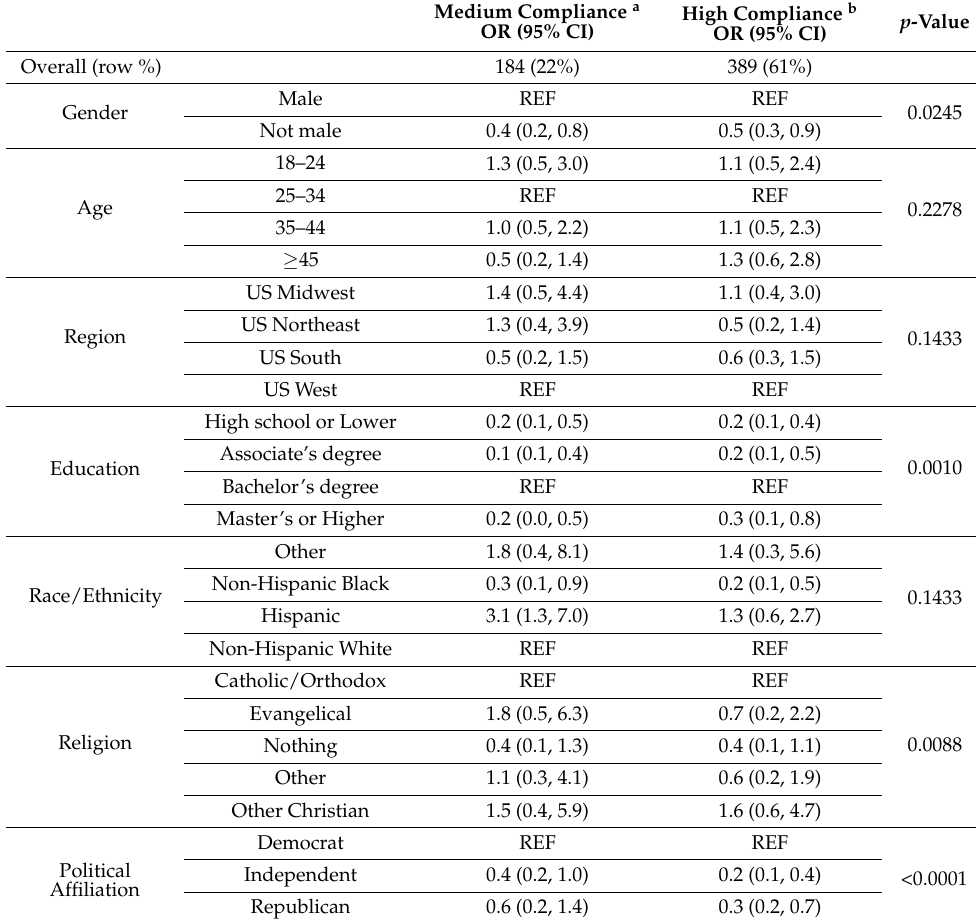
Table 3. Compliance to COVID-19 vaccination guidelines in multinomial, multivariable logistic regression models, United States, August